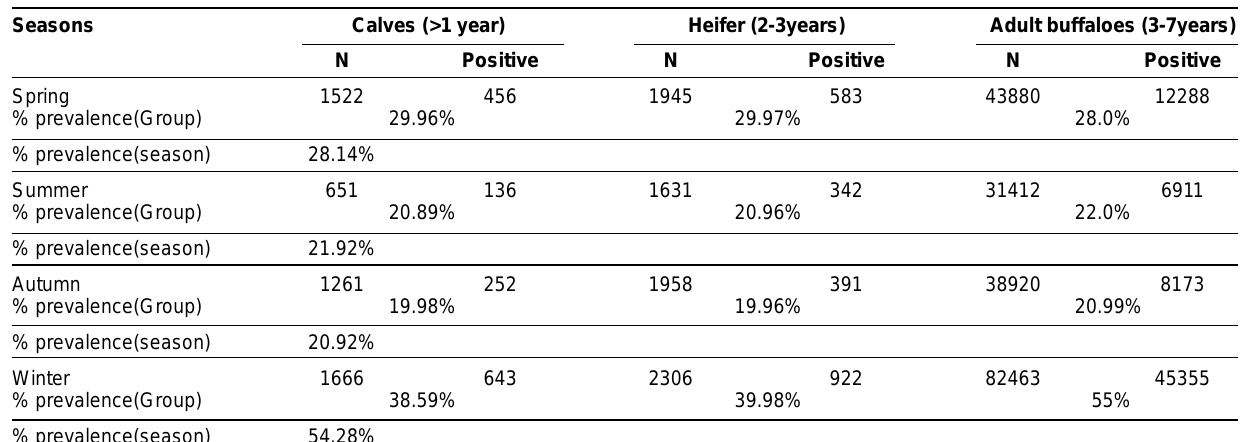
Table-3. Seasonal prevalence of Hydatidosis Seasons